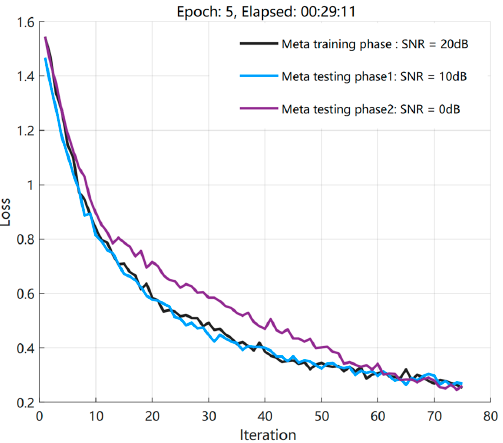
Figure 6. Loss convergence curves under different SNR environments.